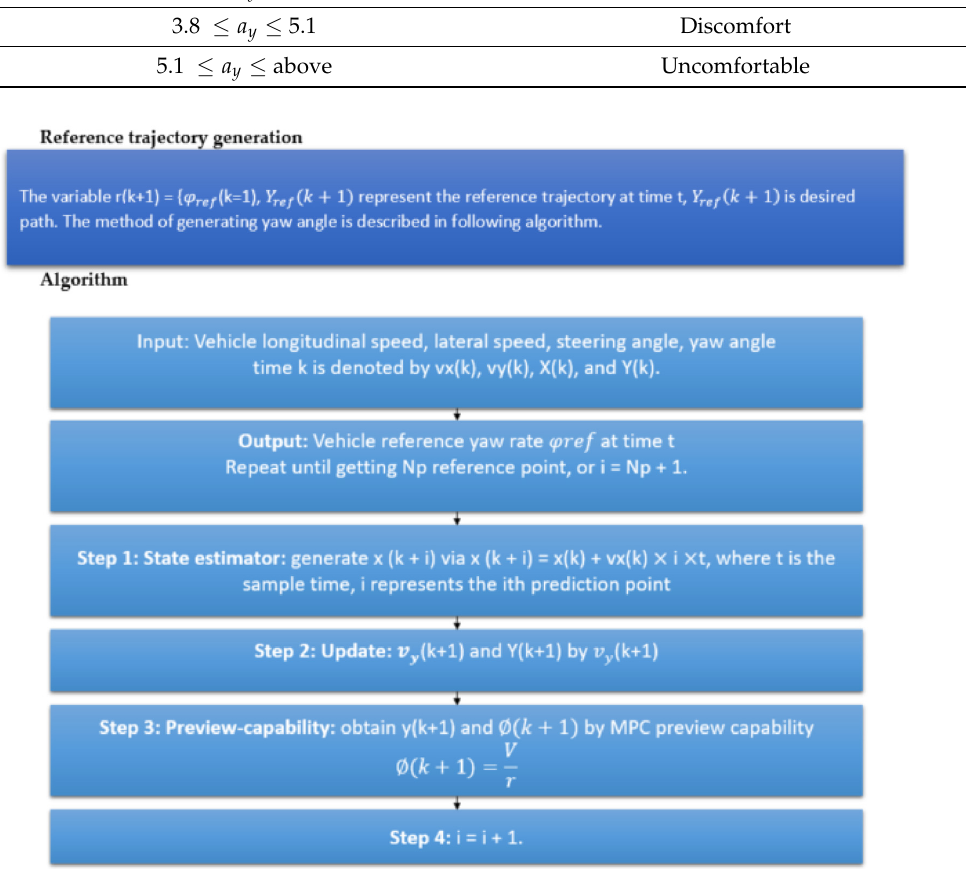
Figure 10. Steps involved in the proposed MPC-PC strategy incorporating a learning-based lane detection algorithm.